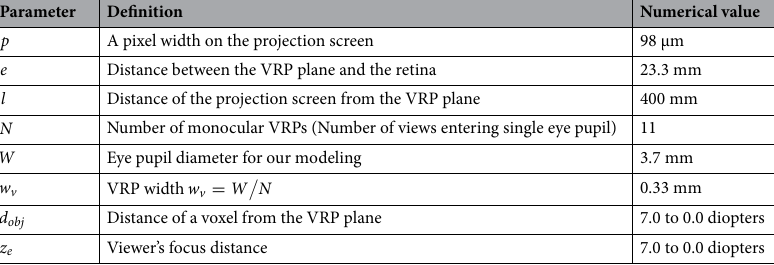
Table 2. System parameters for the proposed BTS- HDSMV